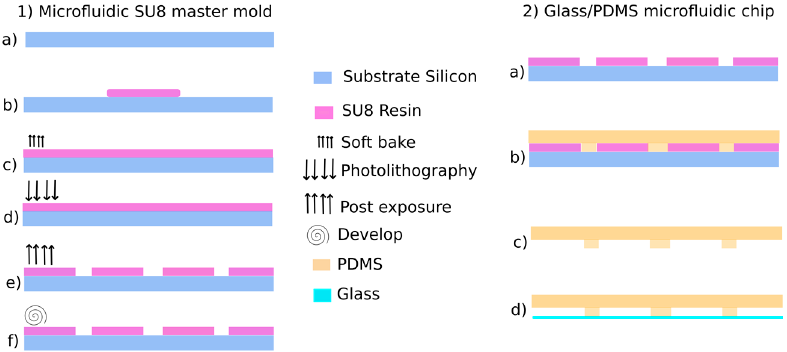
Figure 2. GlassPDMS biochip process: (1) Microfluidic SU8 master mold and (2) Glass/PDMS microfluidic chip